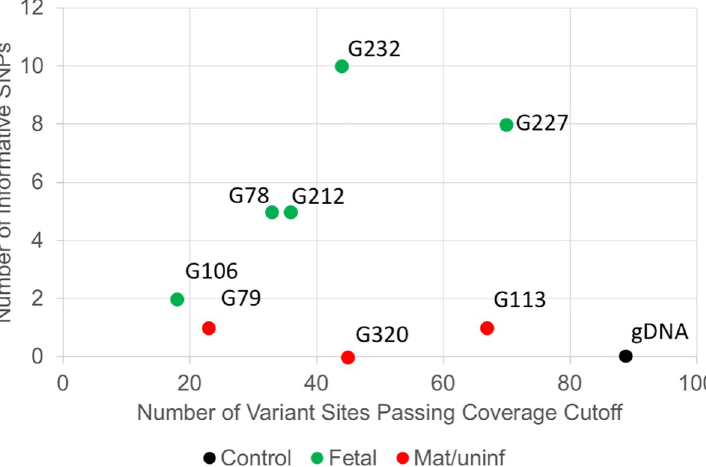
Fig 4. Example of SNP typing result of one NIPT case. The X-axis indicates the number of variant sites passing coverage cutoff. The Y-axis is the number of informative SNPs in a cell. Data from NIPT case number 1000.